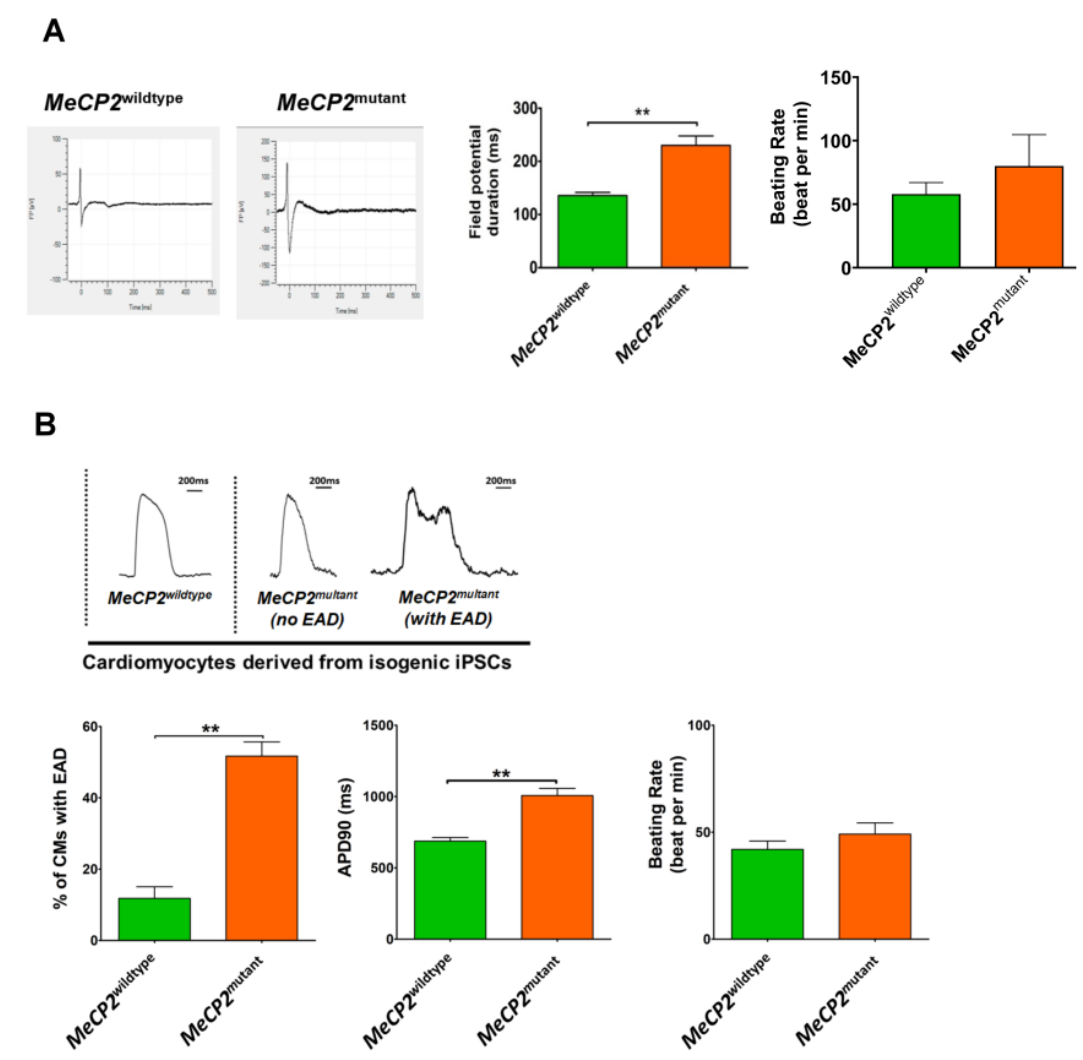
Figure 3. Cardiomyocytes expressing MeCP2 mutant exhibited abnormal electrophysiological proper- ties. ( A ) Representative tracings (left panel), quantitative analysis of the extracellular field potentials recorded by multi-electrode array system (MEA) (middle panel), and the spontaneous beating rates (right panel) of the iPSC-CMs. N = 10 individual recordings from 10 electrodes from 2 MEA plates for each group. ( B ) Representative tracing (upper panel), quantitative analysis of incidences of EAD (lower left middle panel), membrane potential durations (APD90) measured with optical mapping system (lower middle panel), and spontaneous beating rates (lower right panel) of the iPSC-CMs. For the calculation of the percentage of the incidence of EAD, N = 10 calculations of 10 collections of data sets, with each data set comprising 5–10 independent recordings. For APD90 evaluation, N = 50 individual recordings from 50 small cell clusters (2–3 cells/cluster) for each group. Data are represented as mean ± SEM. ** p < 0.01. (See also Figure